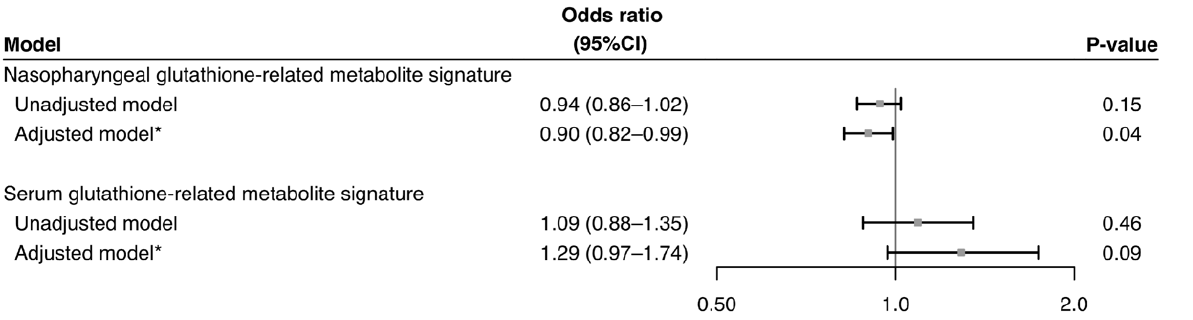
Figure 6. Association of glutathione-related metabolite signatures with risk of developing asthma. The nasopharyngeal and serum glutathione-related metabolite signatures for PPV use were estimated by constructing generalized additive models. Then, the association of the signature with the risk of developing asthma was estimated by fitting logistic regression models. The ORs were estimated in a change in the weighted sum of the glutathione-related metabolite coefficients. * Esti- mated by fitting logistic regression model adjusting for potential confounders (age, sex, race/ethnicity, prematurity, daycare use, cigarette smoke exposure at home, maternal smoking during pregnancy, parent history of eczema, RSV infection, RV infection, and any IgE sensitization). Abbreviations: CI, confidence interval; IgE, Immunoglobulin E; OR, odds ratio; PPV, positive pressure ventilation; RSV, respiratory syncytial virus; RV, rhinovirus.